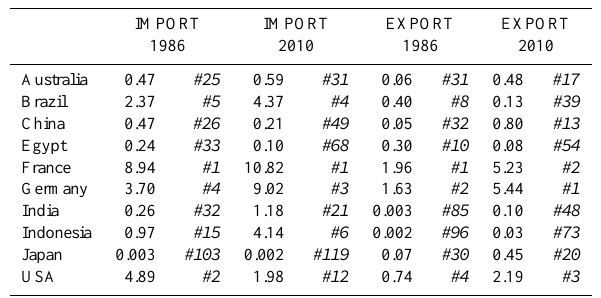
Table 2. Volumes of virtual water imported/exported by Italy in 1986 and 2010 from/to specific countries (in km 3 yr − 1 ) and (in italic) positions of each country in the ranking for the major vol- umes exchanged with Italy in the two years.